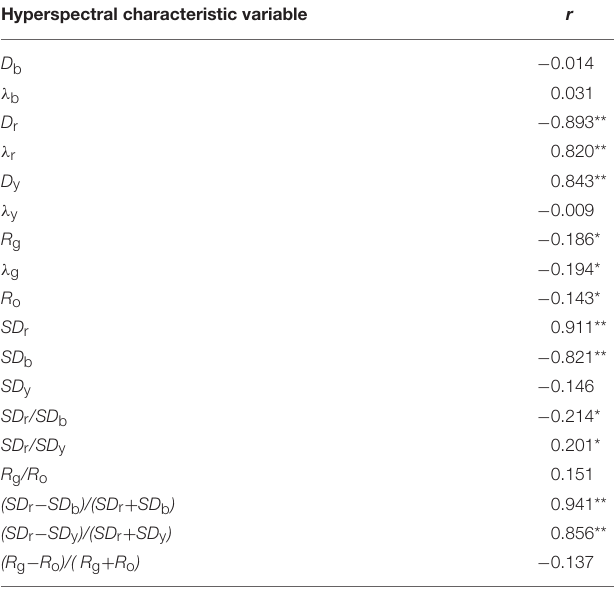
TABLE 3 | Correlation coefficients between hyperspectral characteristic variables and wheat LNA ( n = 144). Hyperspectral characteristic